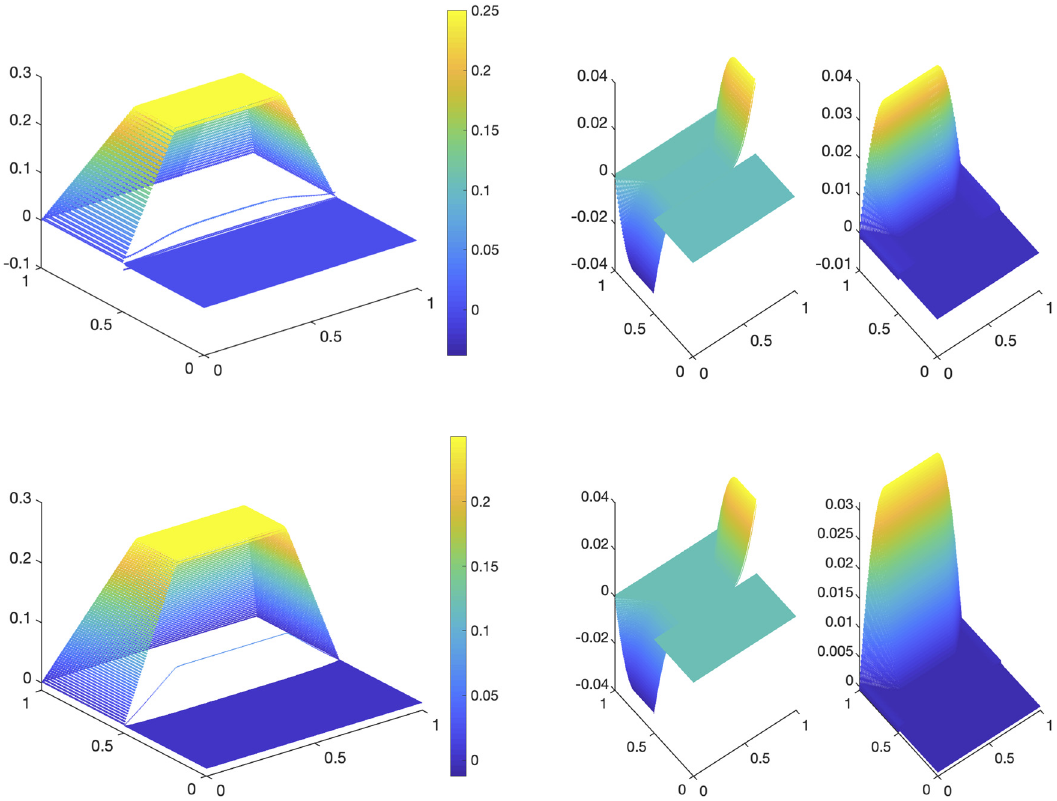
when the meshsize h 8.4984 10 −5 = × . Bottom row: u h and p h